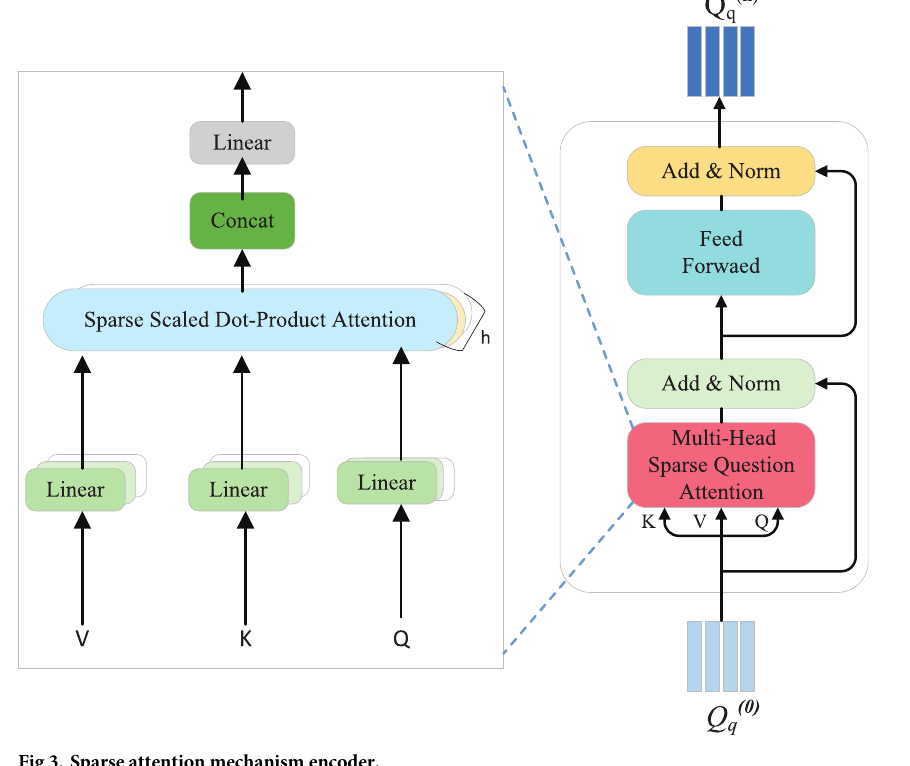
Fig 3. Sparse attention mechanism